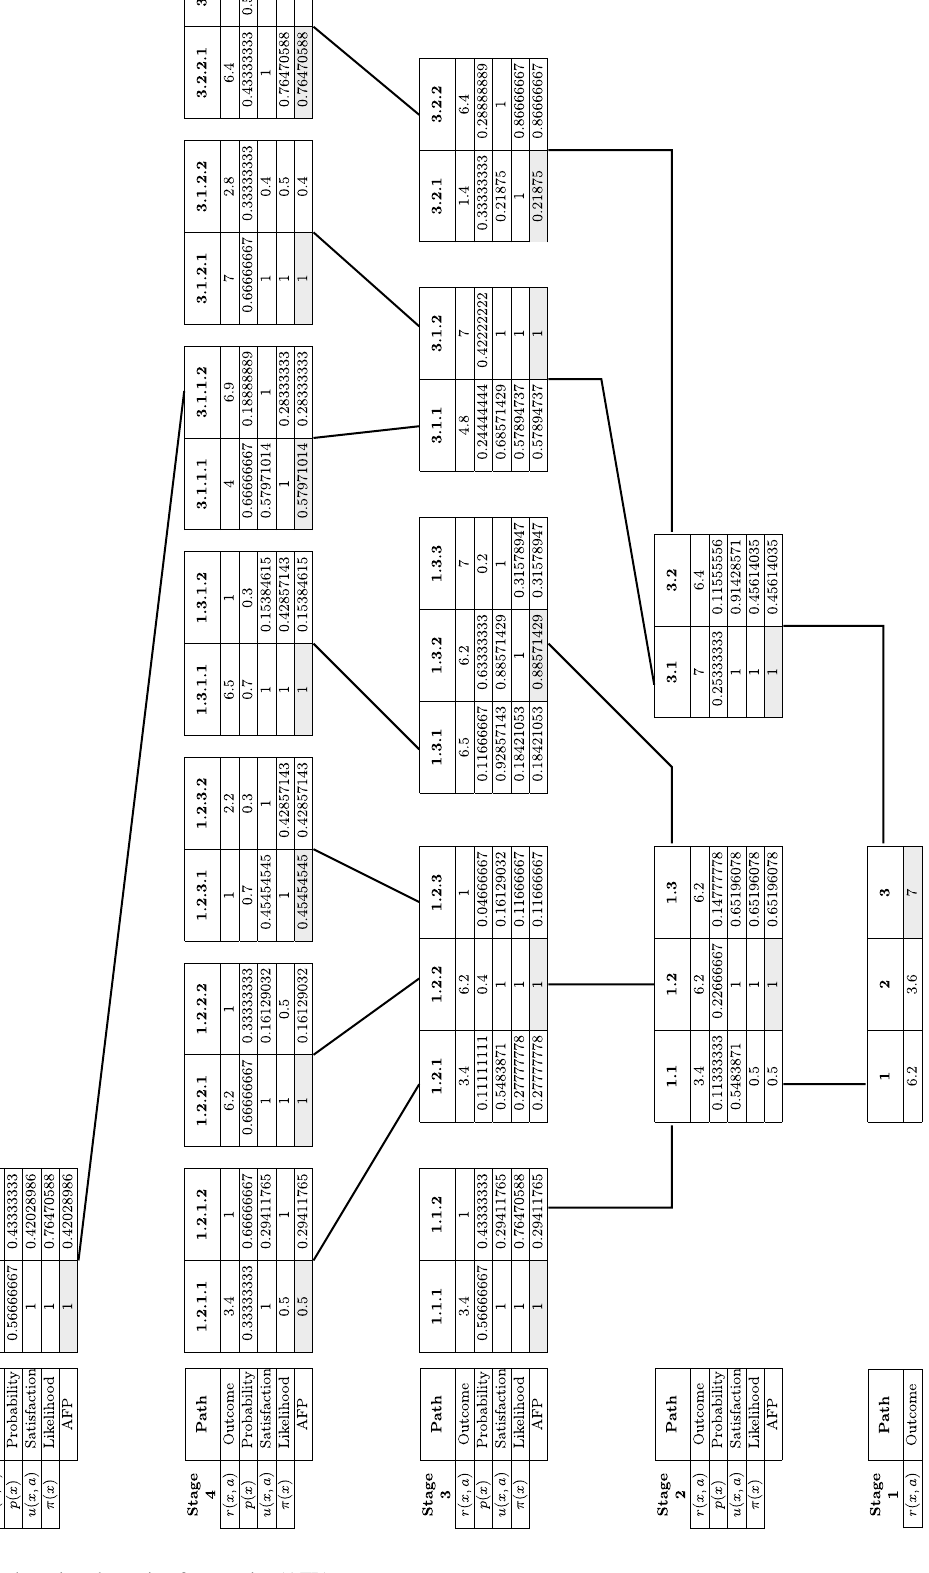
Fig. 3 MOSDMA results using the active focus point